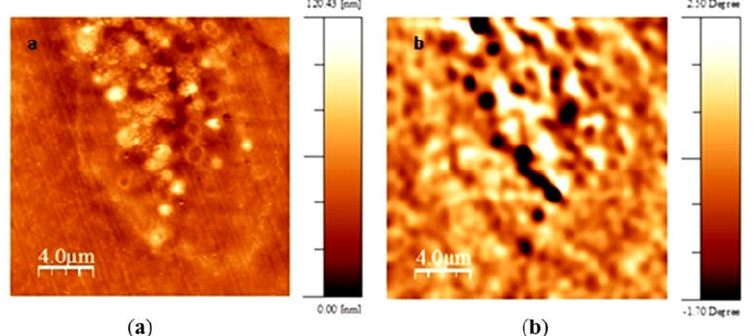
Figure 5. Atomic force microscopy/magnetic force microscopy (AFM/MFM) of 21 days mms6 -transfected MSCs. Topographic AFM image obtained in semi-contact mode ( a ) and its corresponding MFM phase image ( b ), obtained at 30 nm lift distance. Positive and negative signals contrast corresponding to intracellular aggregates.